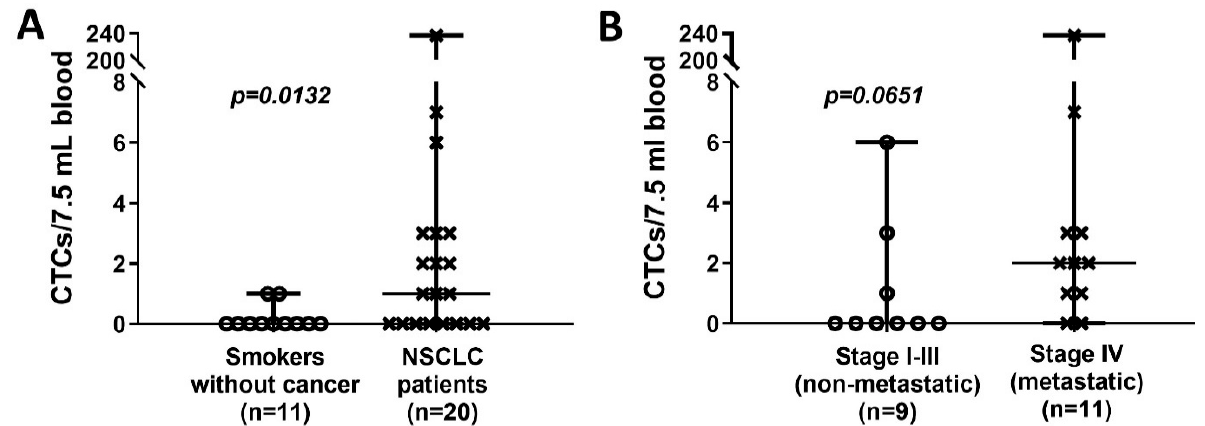
Figure 2. CTC counts in the study populations. (A) . CTC counts in high-risk controls (long-term smokers) without cancer and patients diagnosed with NSCLC. ( B) . Distribution of CTC count for NSCLC patients by tumor stages, separating them in localized/loco-regional stage I–III versus advanced, metastatic stage IV. (Scatter dot plots; p values were calculated with Mann–Whitney test).